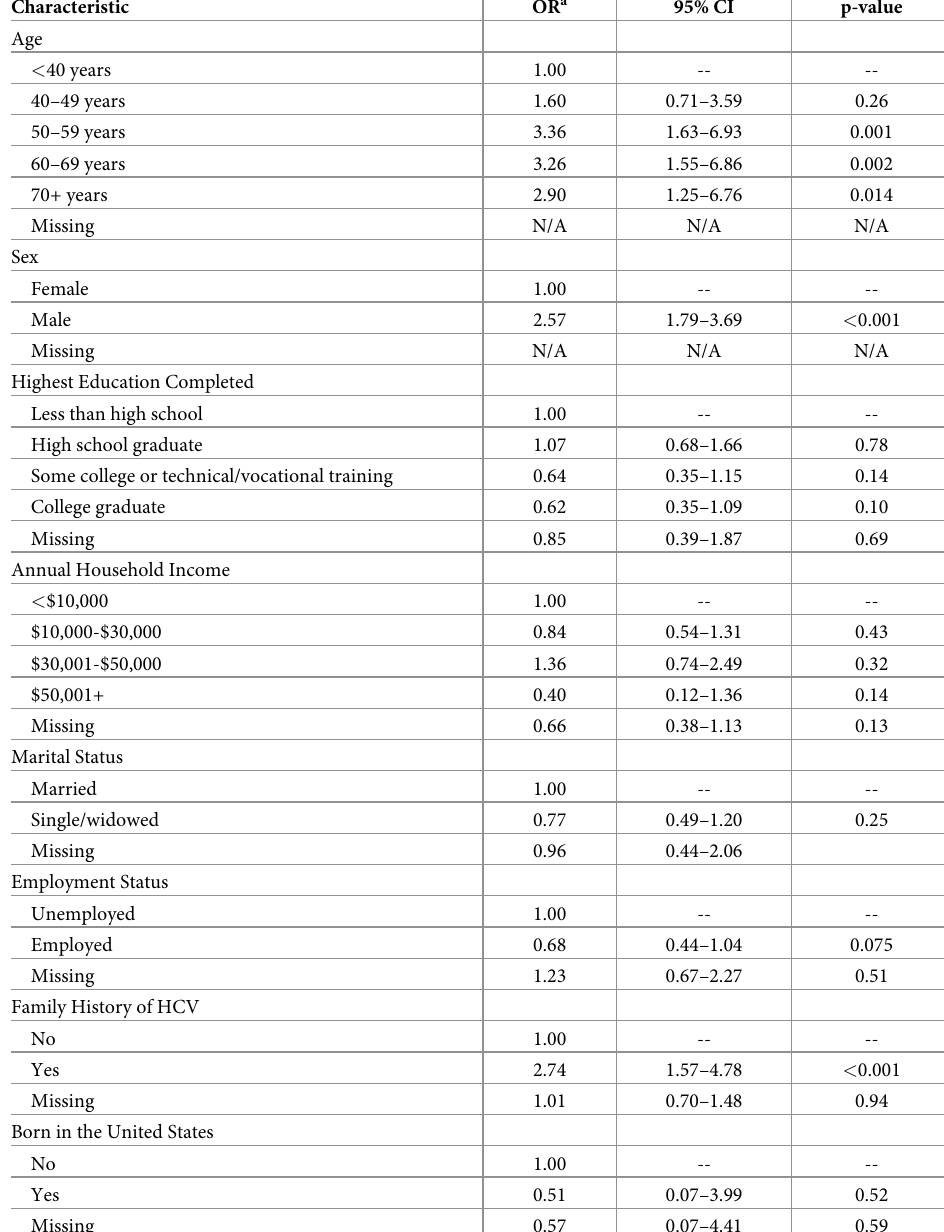
Table 2. Multivariate logistic regression analysis of characteristics and their associations with HCV infection.